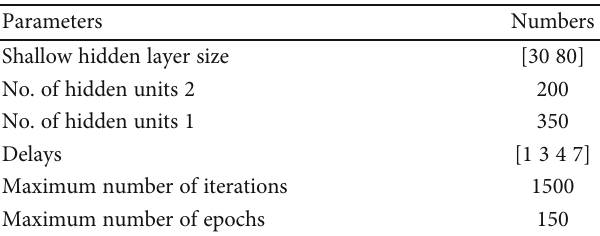
Figure 5: Architecture of the LSTM model. Table 5: Parameters of the LSTM model.